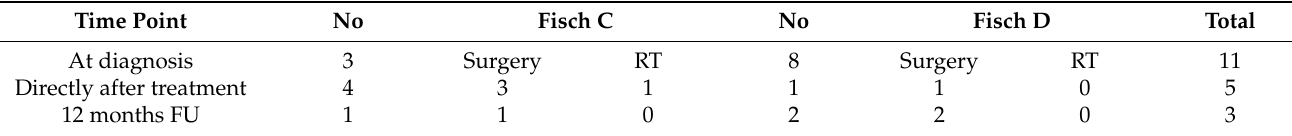
Columns “Surgery” and “RT” represent additional paresis after treatment modality. Columns “No” represent the number of affected patients. Rows indicate number of patients with pre-existing or new CNP at each time point. For the sake of overview, column “Total” represents exclusively new acquired paresis at time points “Directly after treatment” and “12 months FU”. CNP, cranial nerve palsy; FU, follow-up; RT,